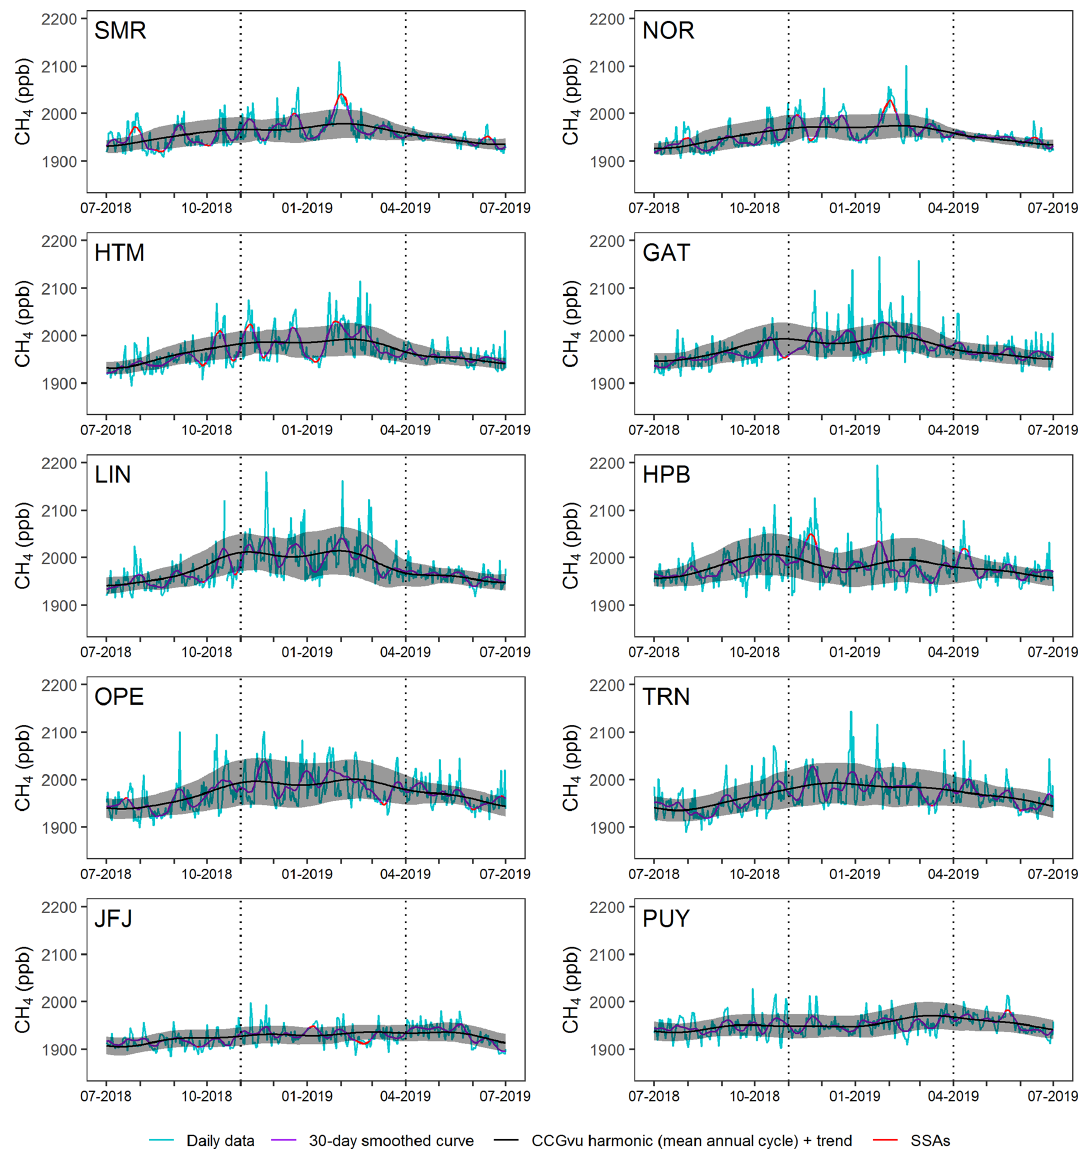
Figure 5. Daily aggregated CH 4 readings for 1 July 2018–1 July 2019 (blue). The background signal derived using the CCGCRV harmonic + trend curve is shown in black. The gray envelope represents the ± 2 σ range of the 30d smoothed cycle about the background signal, and the purple curve is a 30d smoothing of the daily data. SSAs are highlighted in red. Dashed lines show the extended winter